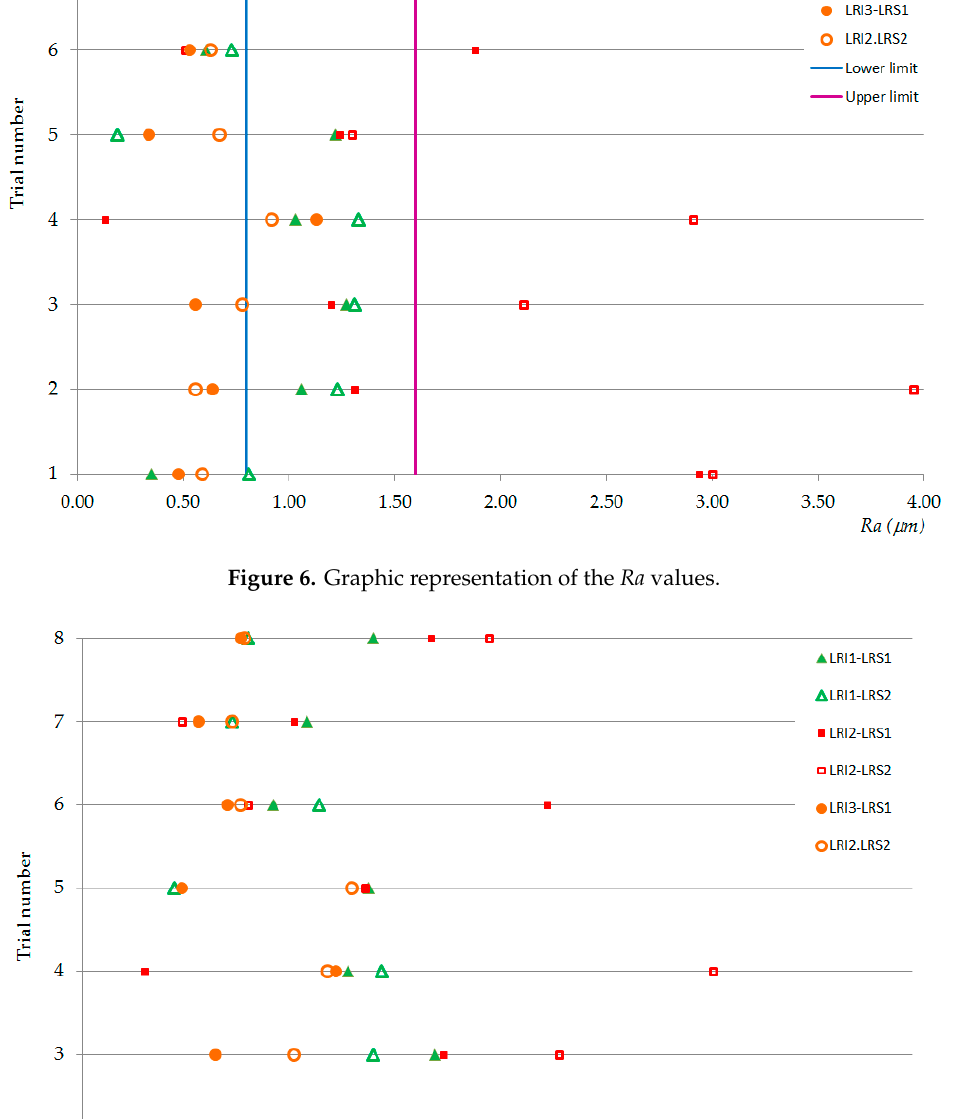
Figure 5. Normal distribution of Ra (µm) and Rz (µm), respectively, with respect to ( a ) and ( b ) feed rate, f (mm/rev); ( c ) and ( d ) spindle speed, N (rpm); ( e ) and ( f ) type of cooling system, C ; ( g ) and ( h ) location regarding insert, LRI; ( i ) and ( j ) location regarding specimen , LRS .